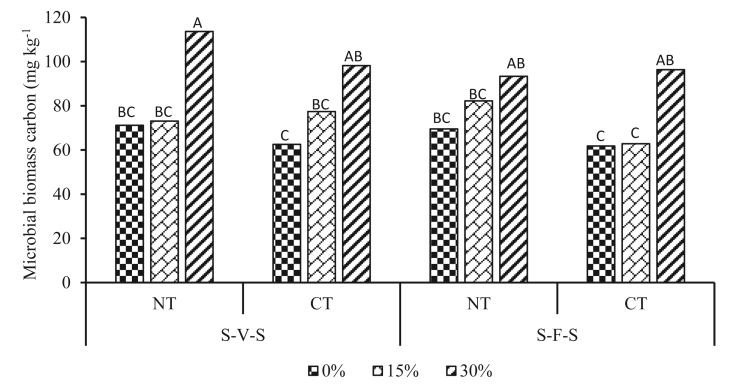
Tillage, crop rotation, and residue management interaction influence on MBC. Different uppercase letters indicate significant differences at P ≤ 0.05. NT: no-till, CT: conventional tillage, S-V-S: sweet sorghum-grazing vetch-sweet sorghum, S-F-S: sweet sorghum-fallow-sweet sorghum, bars with similar letters are not statistically different.